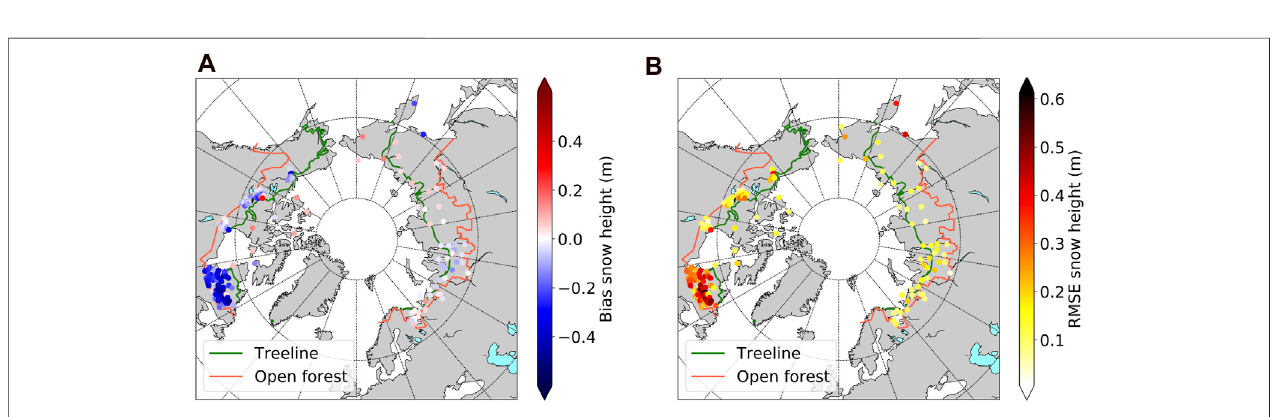
FIGURE 5 | Same as Figure 4 but for snow